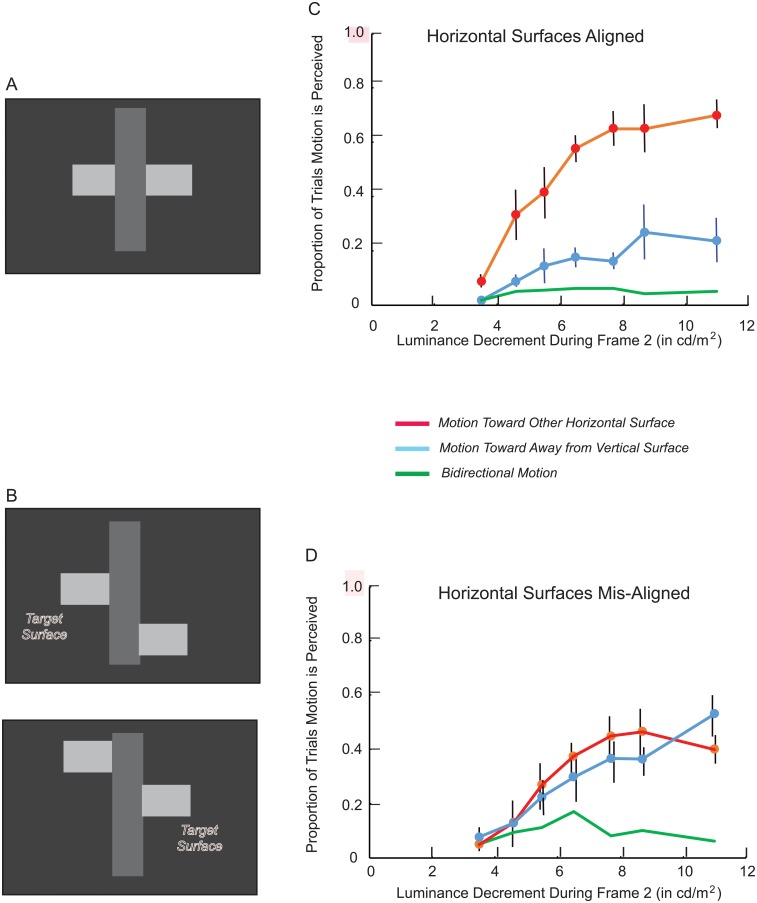
Experiment 1: Stimuli and results.Stimuli: Horizontal surfaces are aligned (A) or mis-aligned (B). When mis-aligned, the target horizontal surface always was centered with respect to the vertical surface. illustrative demos are included with the Supplementary Information (S1 and S2 Movies). Results: In the aligned (C) and mis-aligned (D) conditions, the proportion of trials motion was perceived in a direction indicating that the decremented horizontal surface was grouped with either the other horizontal surface, or with the central, vertical surface. Included in panels C and D are the proportions of trials ‘bidirectional’ motion was perceived. Vertical lines in panels C and D indicate +/- one standard error. Standard errors smaller than the markers are omitted.